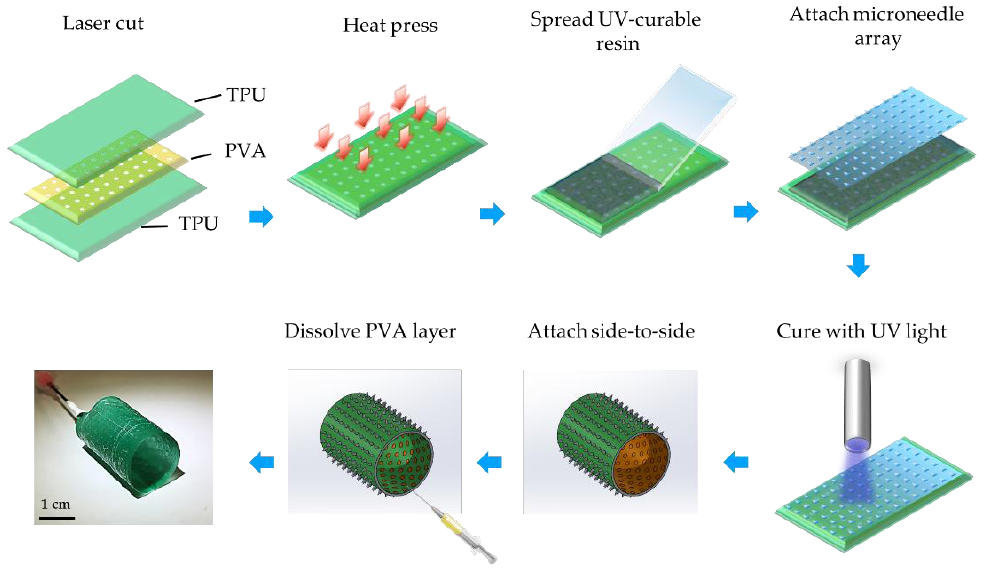
Figure 2. Schematic for microneedle patterning in a rapid prototyped soft robotic polyurethane stent. TPU sheets were laser-cut into a stent design matching porcine aorta. Water-soluble polyvinyl alcohol (PVA) films were laser-cut to obtain an array with hexagonal holes. The combined layers were then heat-pressed (136 °C, 25 kN for 30 min). The top TPU layer was covered with a UV-curable adhesive and attached to the microneedle array. The adhesive was then cured by short exposure to UV light. The planar stent was then rolled into a cylinder, and its edges were glued together. The PVA layer was then dissolved in water using a